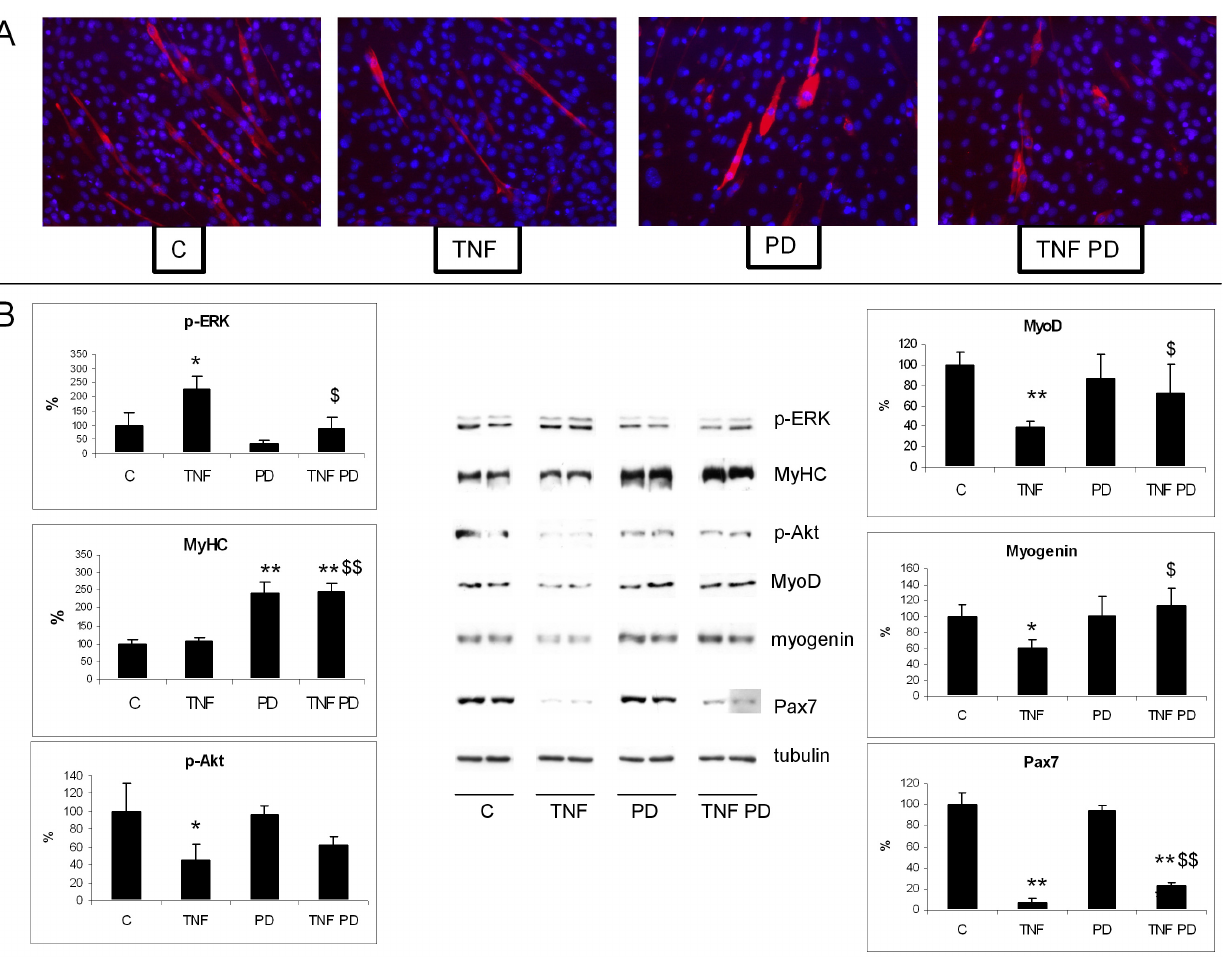
Figure 6. ERK inhibition promotes myogenic differentiation of C2C12 cells. Subconfluent C2C12 cells switched to DM and simultaneously treated for 48 h with 100 ng/ml TNF a in the presence or in the absence of PD (20 m M). (A) MyHC immunostaining. (B) Protein expression levels of p- ERK, MyHC, p-Akt, MyoD, myogenin and Pax7. Densitometric quantifications were normalized according to tubulin levels. Data (means 6 SD; n=3) expressed as percentages of controls. Significance of the differences: *p , 0.05 vs C; **p , 0.01 vs C; $ p , 0.05 vs TNF a ; $$ p , 0.01 vs TNF a .